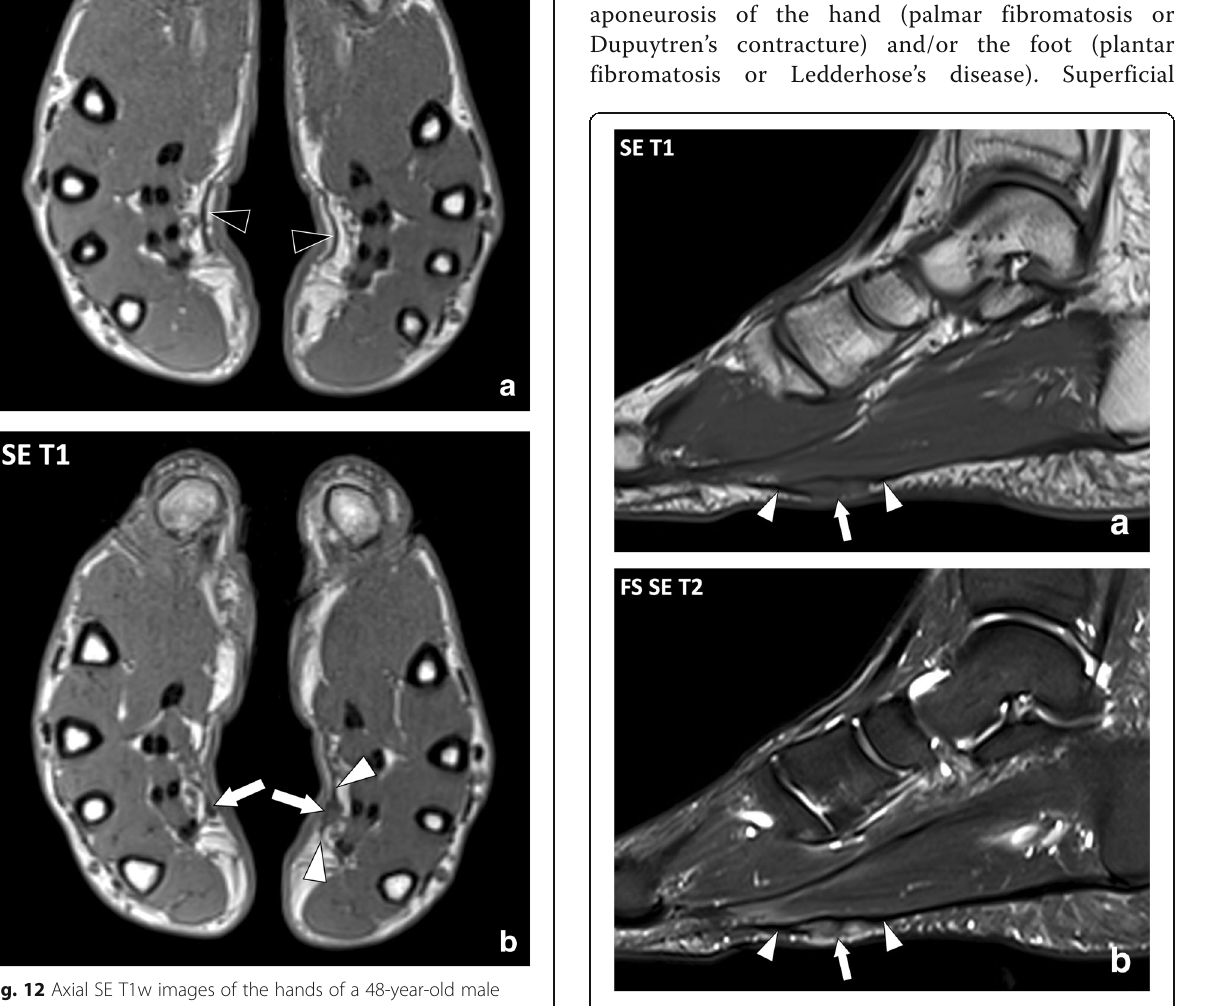
Fig. 13 Sagittal ( a ) SE T1w and ( b ) fat-suppressed SE T2w images of the right foot of a 47-year-old male with plantar fibromatosis. MRI demonstrates fusiform thickening of the plantar fibromatosis with a nodule of low signal intensity on the T1w image and heterogeneous high signal intensity on the T2w image (arrow) in continuity with the normal aponeurosis